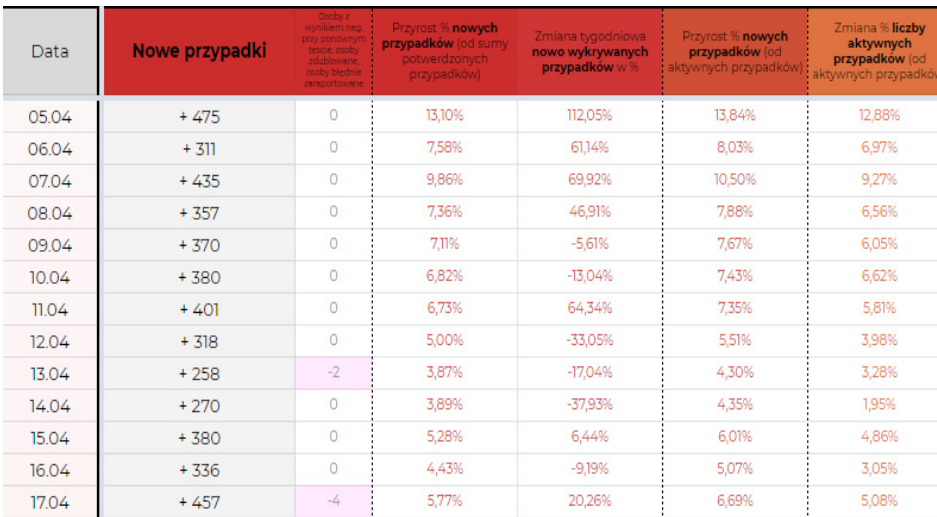
Figure 1. Example screenshot from the dataset with statistics from Poland, showing new cases, percentage of the increase of cases, weekly change of newly recognized cases, percentage increase of new cases compared to the active cases, and percentage change of number of active cases [16].